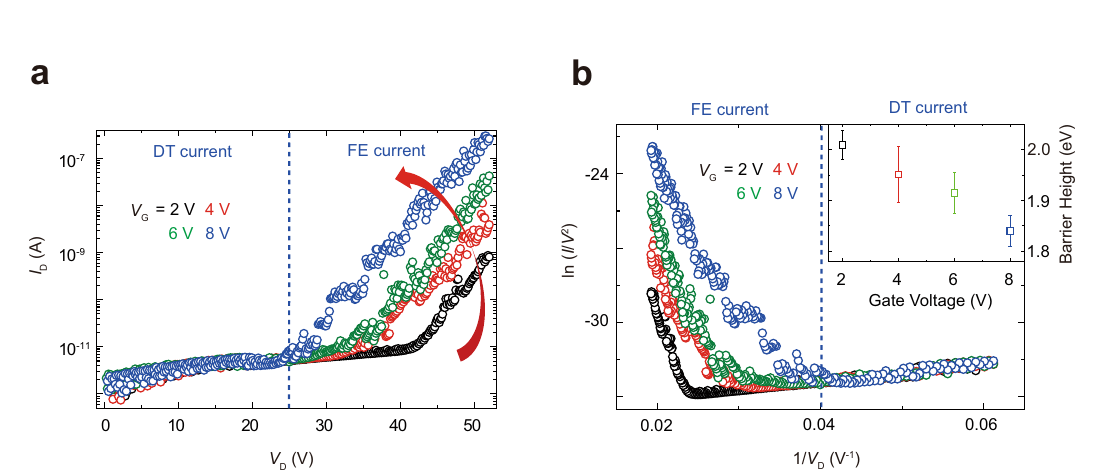
Fig. 1 Fabrication of the FEB and its semiconductor-less device characteristics. a Optical microscopic image of an FEB consisting of stacked metal/ h BN/ graphene/ h BN/metal (scale bar 20 μ m). (inset) Scanning electron microscopic image of polymethyl methacrylate (PMMA) bridges, which help thin metal electrodes connect through the thick stack (scale bar: 5 μ m) (for more detail, see the “ Methods ” section). b Schematic diagram of the FEB applying V D and V G . c , d Band diagrams of the FEB ( V D > 0) under FE-dominant ( c ) and DT-dominant conditions ( d ). The V G modulates the accumulation of electrons on the graphene. e , f Band diagrams of the FEB ( V D < 0) under DT-dominant ( e ) and FE-dominant conditions ( f ). The V G modulates the accumulation of holes on the graphene. The gate voltage decreases from c to f . g I D switching performance of the semiconductor-less device. I D − and I G − are drain and gate current under V D = − 18 V. I D + and I G + are drain and gate current under V D = 29 V. For the negative V G , I ON / I OFF above 10 6 has been achieved at 300 K. h Device characteristics of the n-type FEB ( V D > 0) at 300 K (left) and 15 K (right). i Device characteristics of the p-type FEB ( V D < 0) at 300 K (left) and 15 K (right). For both types, very little temperature degradation of I D was observed. j I D switching under V D = − 18 V (red) and 29 V (black) also exhibited little temperature degradation from 400 to 15 K.